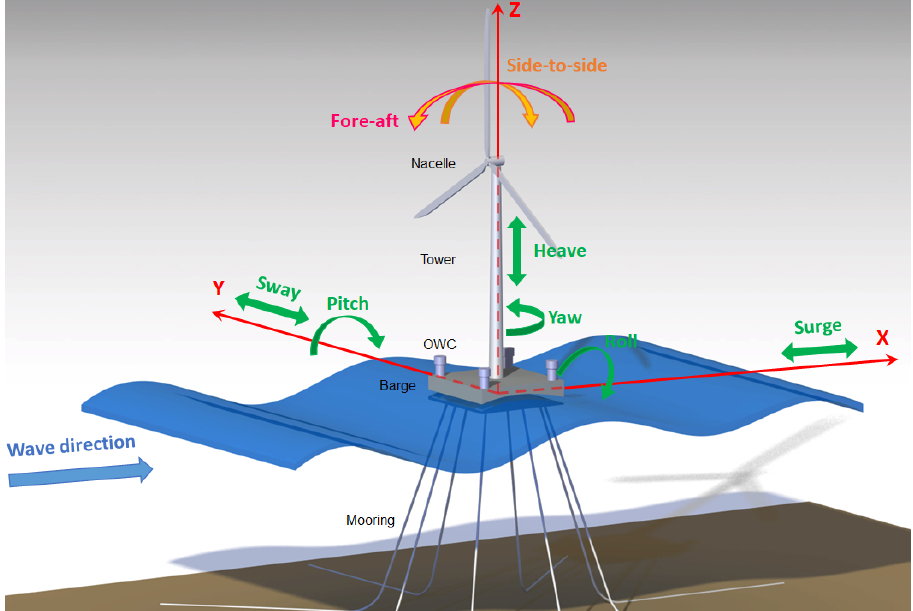
Figure 1. Barge-based floating offshore wind turbine with four OWCs.